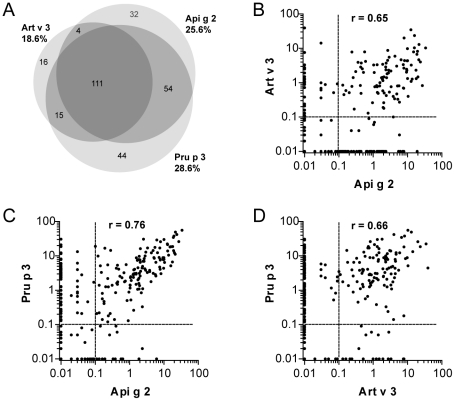
Sensitization to celery, mugwort pollen and peach LTP in a Mediterranean population.786 individuals were screened for IgE reactivity to rApi g 2, rArt v 3, and nPru p 3 using an allergen microarray and co-sensitization patterns are shown in the Venn diagram (A). Statistical significant correlations of allergen specific IgE reactivity presented as kUA/L (p<0.0001) were observed for Api g 2, Art v 3 and Pru p 3 using the Spearman correlation test (B-D).